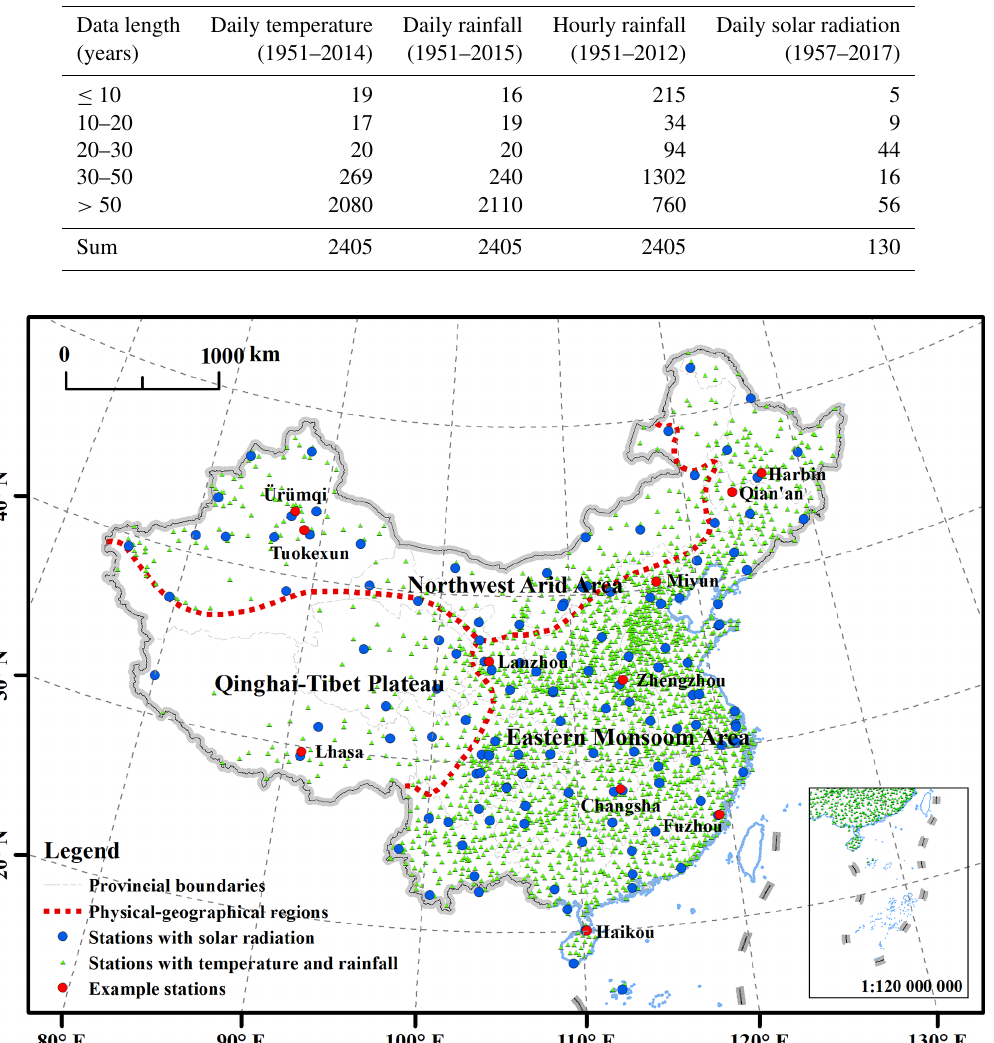
SD SOL are used to generate daily solar radiation and can be directly obtained from observed daily solar